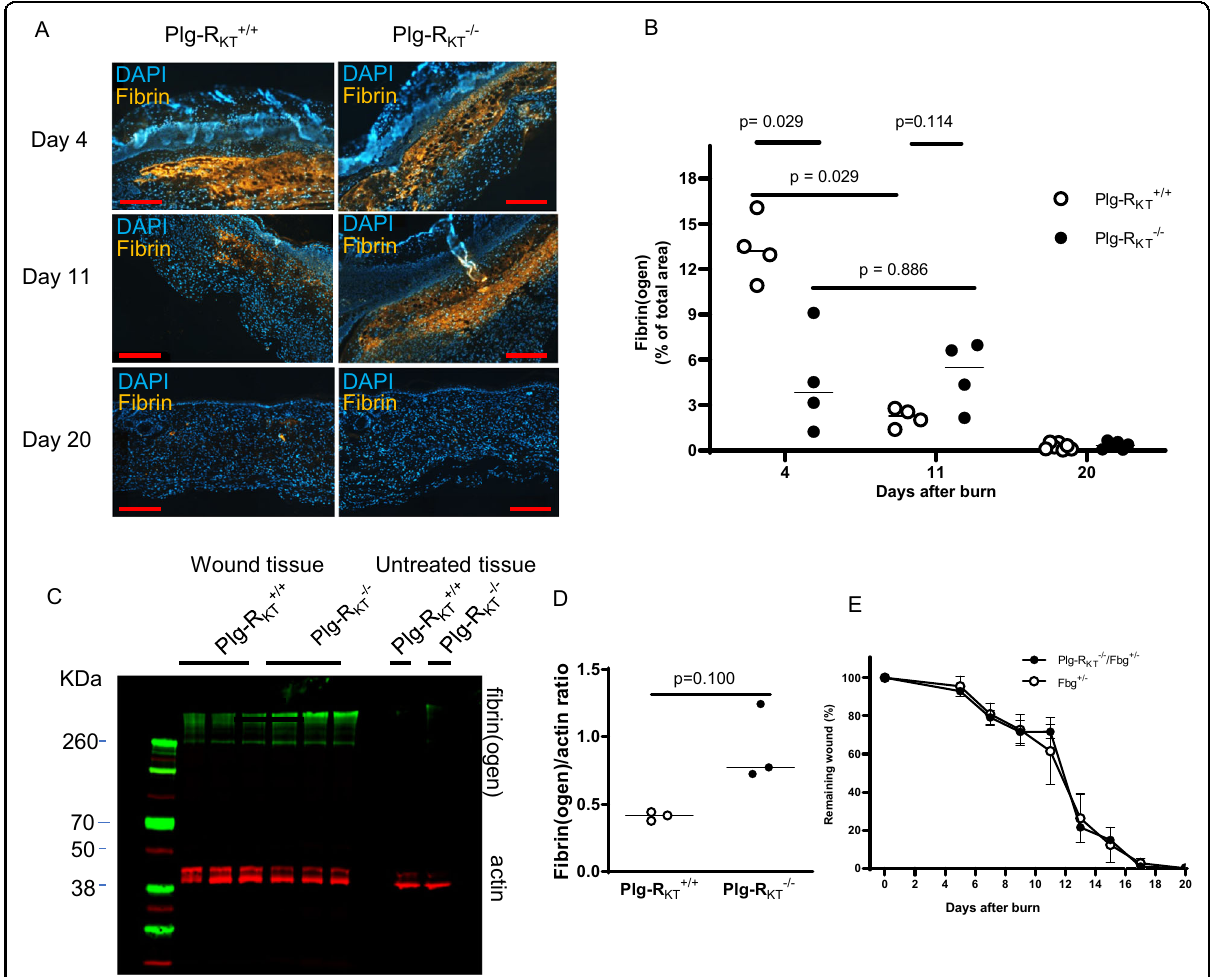
Fig. 7 Enhanced fi brin(ogen) content in Plg-R KT − / − wound tissue and the effect of fi brinogen heterozygosity on burn wound healing. A Immunohistochemical staining for fi brin in the tissue of Plg-R KT − / − and Plg-R KT + / + mice collected at different time points after induction of burn wounds ( n = 4). Scale bar = 200 µm. Images were captured with a Zeiss Axio Imager Z1 (Zeiss, Oberkochen, Germany) or Nikon A1R Eclipse Ti-E inverted microscope (Nikon Instruments, Amsterdam, Netherlands). B Quanti fi cation of fi brinogen area in panel ( A ) (%) based on